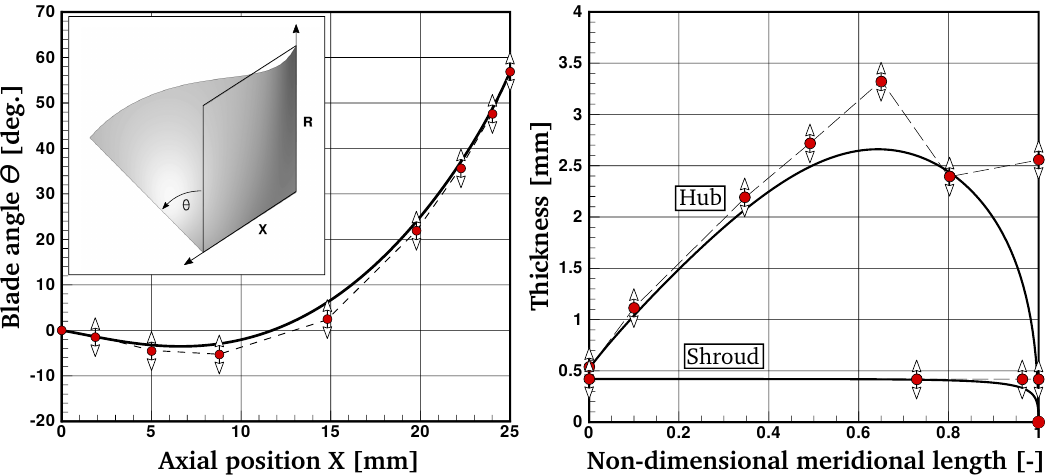
Figure 3. Blade angle θ parameterization ( left ); blade thickness distribution at hub and shroud ( right